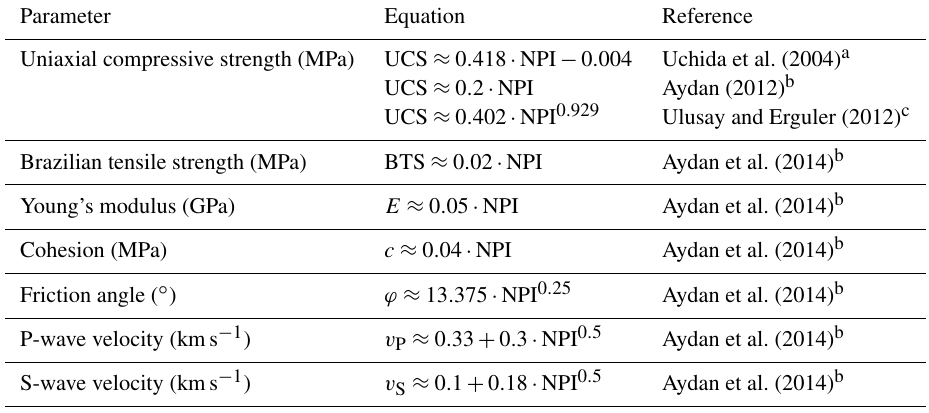
Table 2. Equations for the estimation of physico-mechanical rock parameters using the needle penetration index (NPI), taken from Ulusay and Erguler (2012), Ulusay et al. (2014), and Aydan et al. (2014). The relations are based on compiled experimental data obtained from various